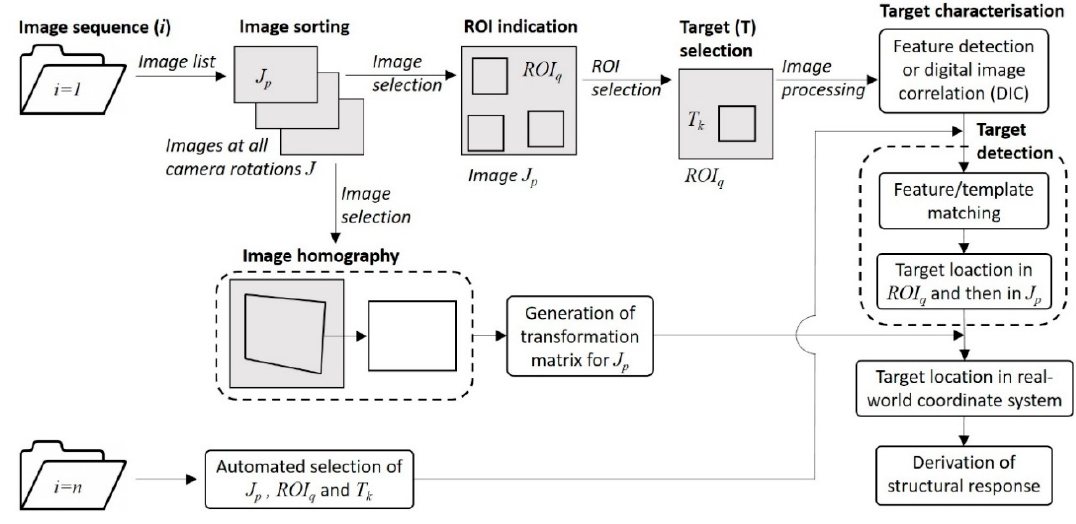
Figure 4. Data processing flowchart